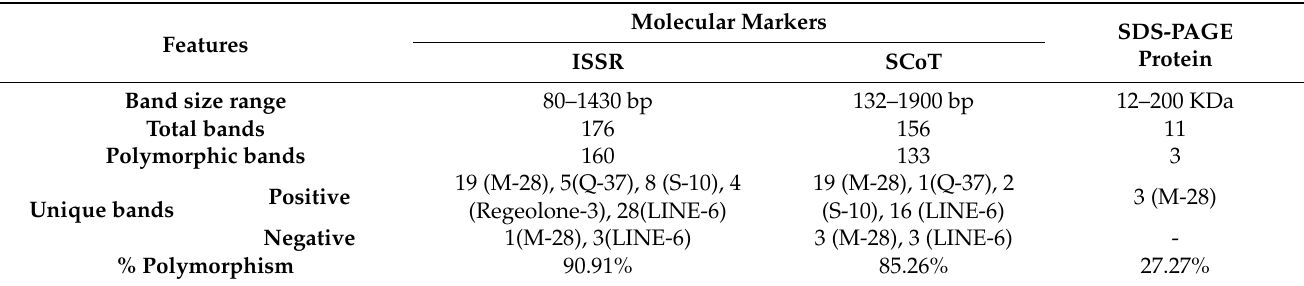
Table 3. Comparison between features generated from molecular markers and protein SDS-PAGE for the studied Quinoa genotypes.